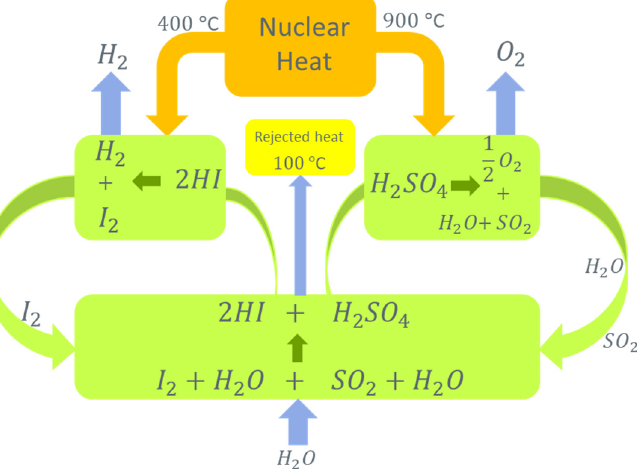
Figure 5. Thermochemical process to produce hydrogen using the heat rejected from a nuclear reactor.